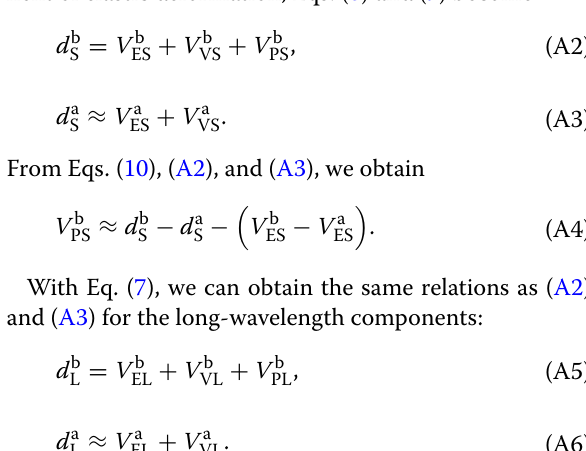
Using Eqs. (A7) and (A12), Eq. (A6) becomes